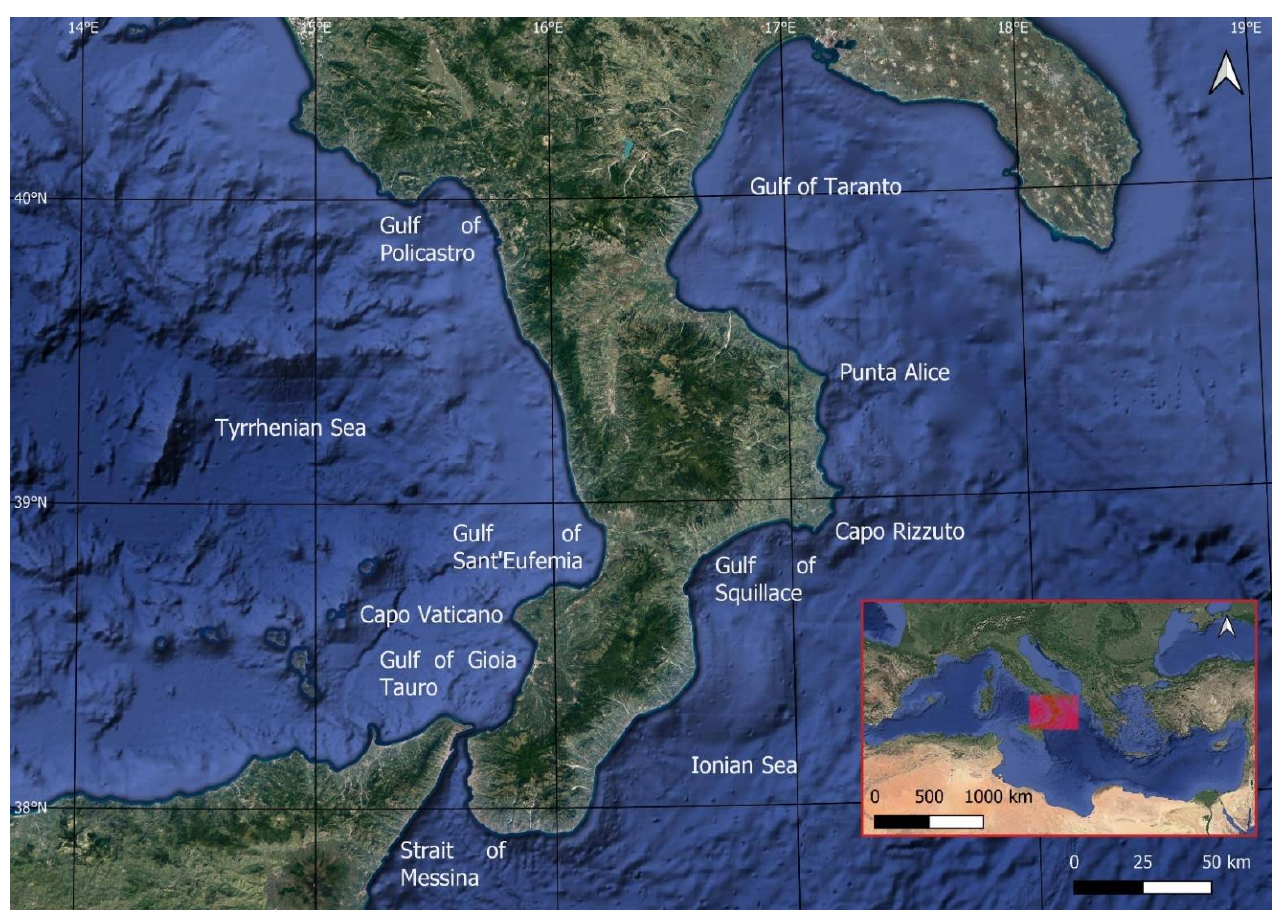
Figure 1. The region of Calabria (large panel). Geographical position of the region of Calabria in the center of Mediterranean Sea (small panel).